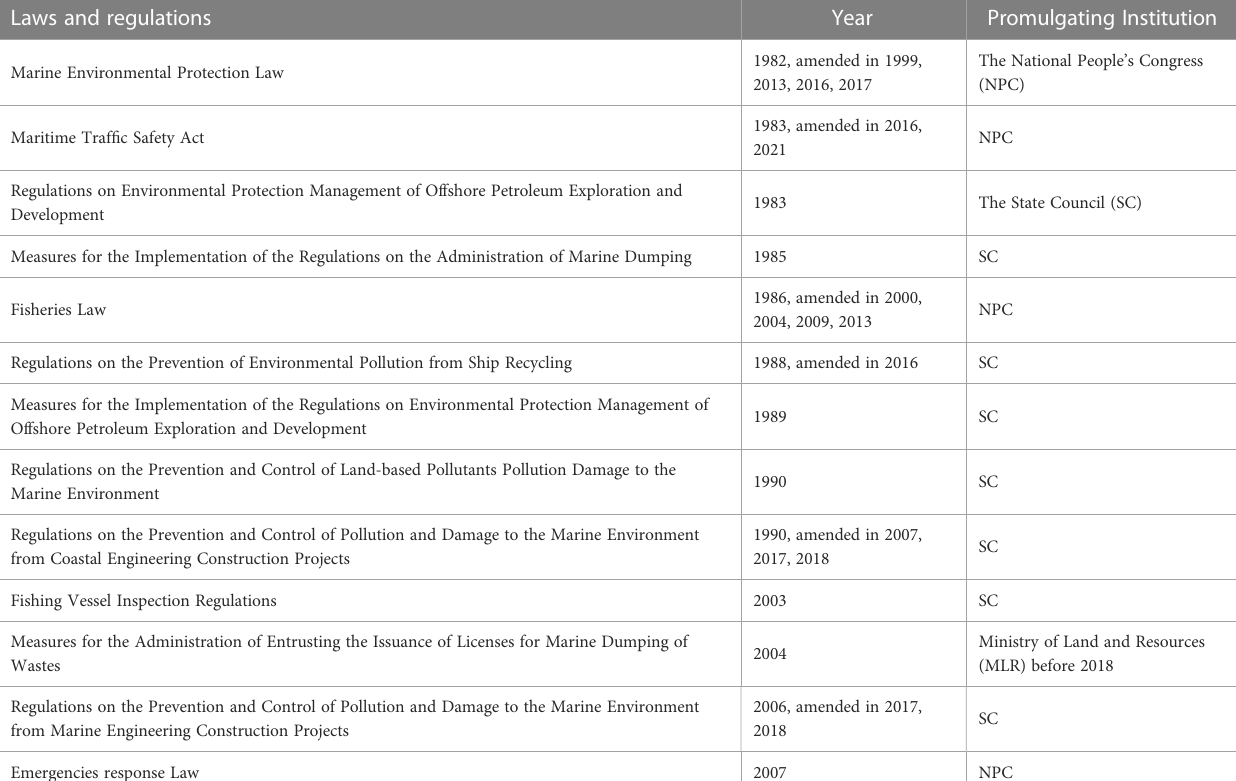
TABLE 2 Laws and regulations issued by the Chinese